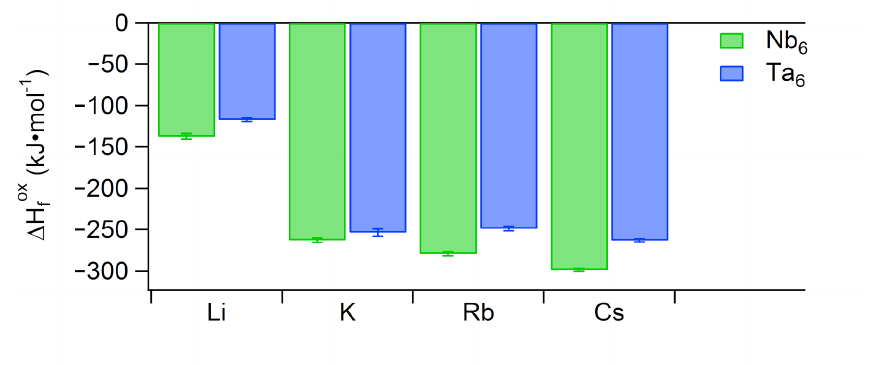
Figure 1. Solid-state ∆ H ox Ta (this study) and Nb 6